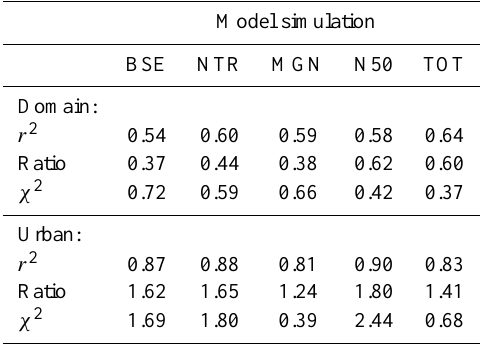
Table 2. Values of the variance ( r 2 ), mean ratio, and reduced chi- squared ( χ 2 ) calculated for all model simulations compared to the GSFC retrievals of tropospheric column NO 2 .